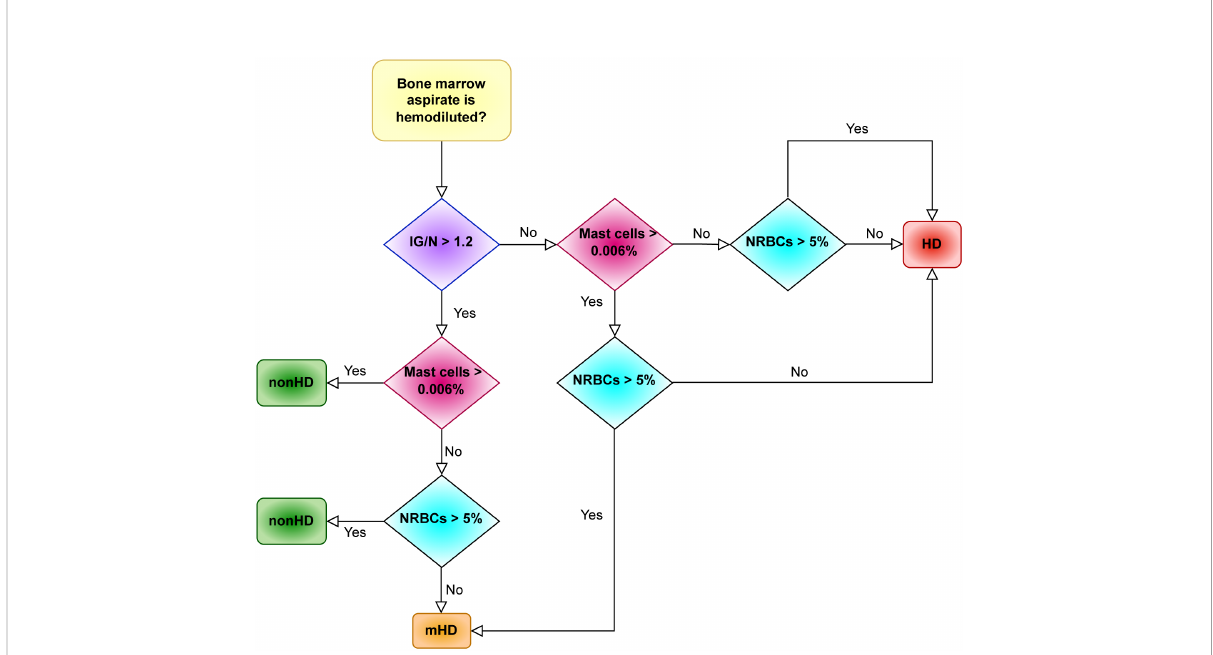
FIGURE 4 The ALLgorithMM sequence. For each BM aspirate, the de fi nition of either hemodiluted or non-hemodiluted sample is the result of at least 2 out of 3 parameters, as analyzed by fl ow cytometry in the BM sample. Immature granulocytes (IG); mature granulocytes/neutrophils (N); erythroblasts (nucleated red blood cells, NRBCs); hemodiluted (HD); mildly hemodiluted (mHD); non-hemodiluted